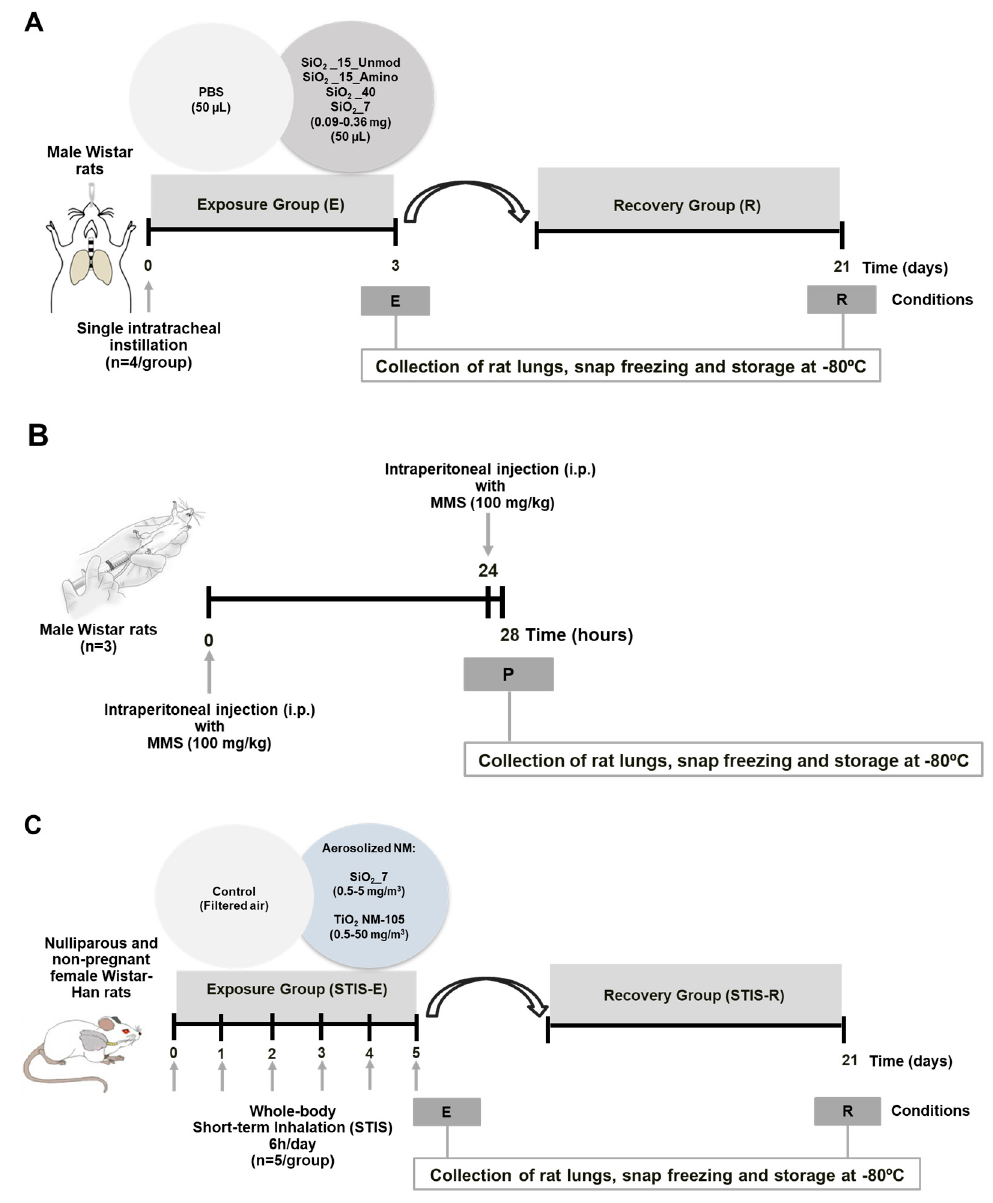
Figure 1. Experimental design of the in vivo studies. ( A ) Male Wistar rats were exposed by intratracheal installation to different doses (0.09, 0.18, 0.36 mg/animal; n = 4/group) of four aSiO 2 NM variants (SiO 2 _15_Unmod, SiO 2 _15_Amino, SiO 2 _40 and SiO 2 _7) freshly dispersed (Cup-Horn, NanoToxClass SOP) in 50 µ L sterile PBS. The control group was intratracheally instilled with the same amount of sterile PBS (Ct; n = 4). The animals were euthanized either 3 days (Exposure group—E) or 21 days (Recovery group—R) after exposure. ( B ) Male Sprague Dawley rats intraperitoneally (i.p.) injected with methyl methanesulfonate (MMS) at a dose of 100 mg/kg ( n = 3), 28 and 4 h before animal euthanasia served as positive controls for the genotoxicity studies. ( C ) Short-term inhalation studies (STIS) were performed in nulliparous and non-pregnant female Wistar-Han rats ( n = 5/group). The animals were exposed (whole-body) during 5 consecutive days for 6 h/day to the aerosolized SiO 2 _7 (0.5, 2, 5 mg/m 3 ) and TiO 2 _NM105 (0.5, 2, 10, 50 mg/m 3 ). Control groups (Ct) were exposed to filtered air. The rats were euthanized at 5 days (Exposure group—STIS-E) after the initial exposure or after a recovery period of 21 days (Recovery